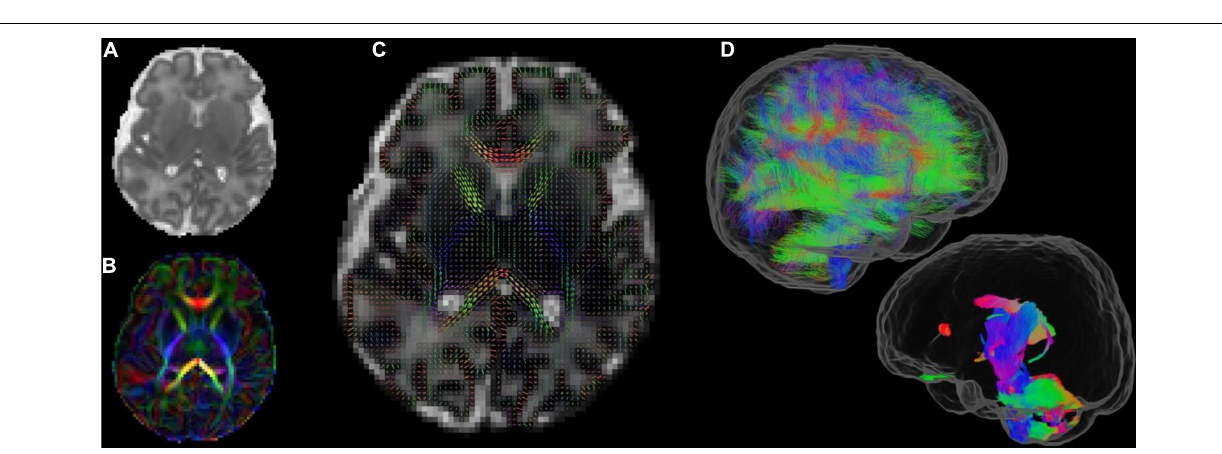
FIGURE 8 | Diffusion MRI metrics in a single subject from the same infant (A) Mean Diffusivity and (B) Color Fractional Anisotropy maps of the Diffusion Tensor Imaging (DTI) model. (C) Tissue Orientation Distribution Function (ODF) of the multi-component analysis in Pietsch et al. (2019). (D) Full brain probabilistic streamline tractography based on the tissue ODF (top image) and based on the mature appearing tissue component (bottom